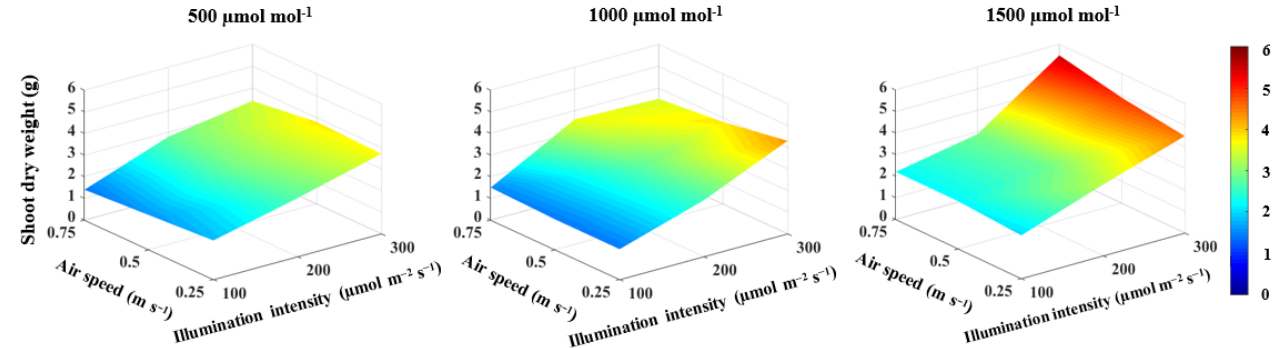
Figure 1. Effect of CO 2 concentration, illumination intensity and air speed on shoot fresh weight of lettuce plants grown under artificial lighting.